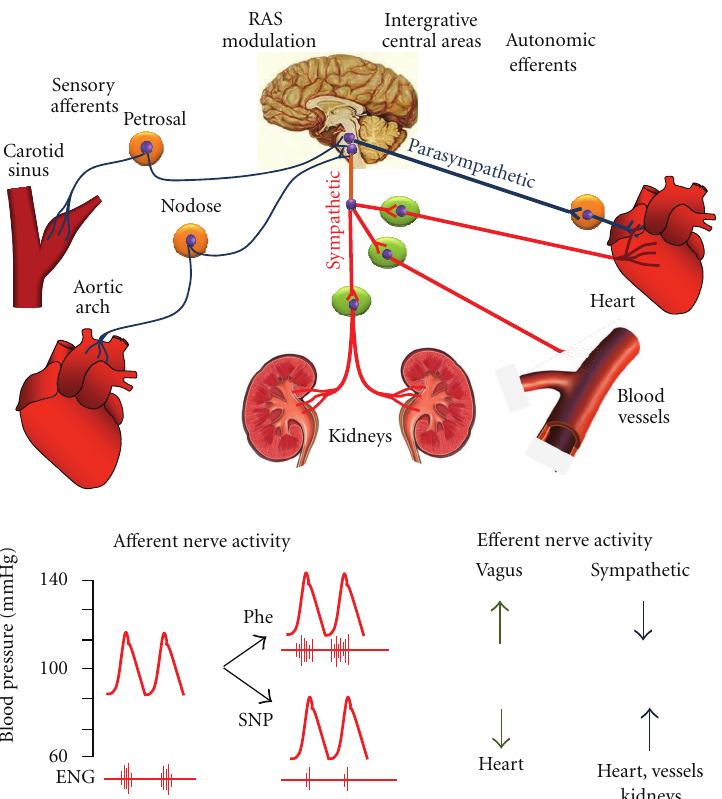
Figure 3: Neuroreflex control of circulation. The top panel illustrates the main neural components of the baroreflex arch. The bottom panel shows a schematic illustration of evaluation of the baroreflex function using the vasoactive agent phenylephrine (Phe) and sodium nitroprusside (SNP) in the murine model of renovascular hypertension. ENG, electroneurogram. The scheme is based on previous publications [3,